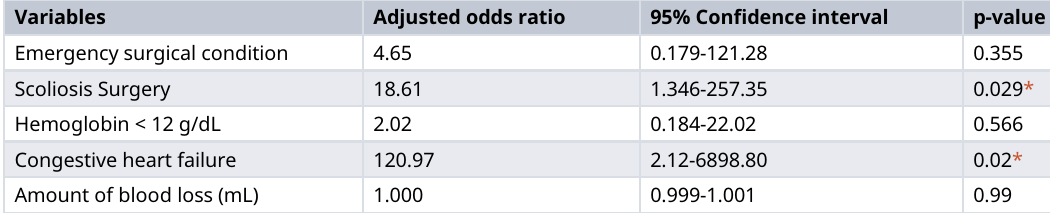
Table 3. Multivariate analysis of the risk for cardiovascular complications in spine